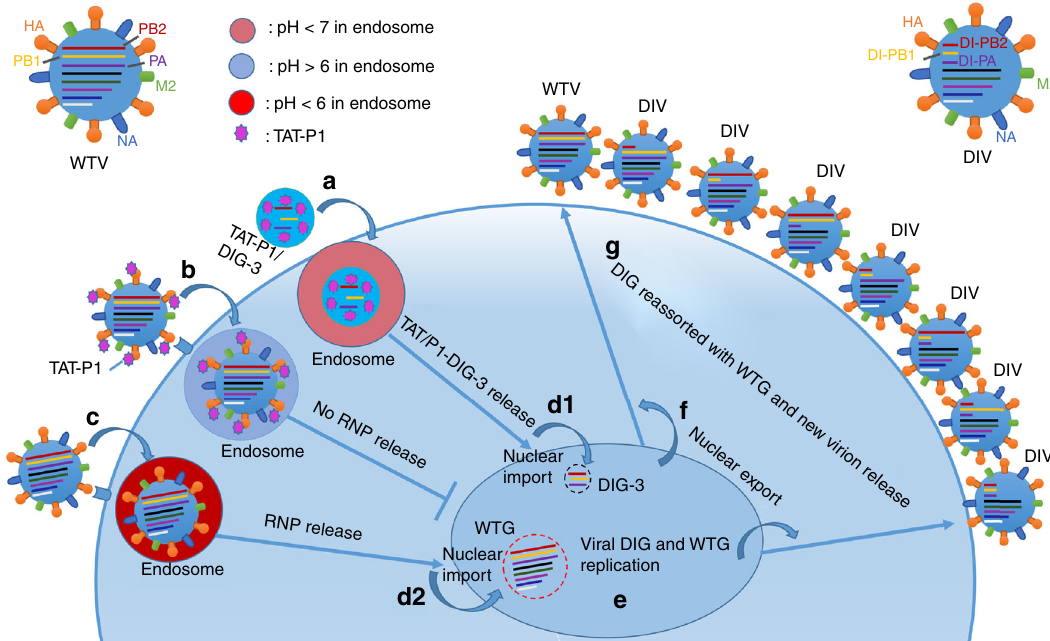
Fig. 8 Schematic model of antiviral mechanism of TAT-P1/DIG-3 in one viral life cycle. When cells are transfected with TAT-P1/DIG-3 and infected with in fl uenza virus, a TAT/P1-DIG-3 are internalized into cells by endocytosis; b Virus can be bound with TAT-P1 and internalized into cells by endocytosis. TAT-P1 can prevent endosomal acidi fi cation to block the release of viral RNP into the cytoplasm and then nuclei; c Some virus particles that are not bound by TAT-P1 might be internalized into cells by endocytosis and undergo endosomal acidi fi cation. d TAT-P1/DIG-3 released from endosomes are imported into nuclei (d1) and viral RNPs released from endosomes are imported into nuclei (d2). e Viral DIG and wild-type genes (WTG) replicate in nuclei. f Newly produced DIG and WTG are exported to cytoplasm. g Viral DIG and WTG are reassorted in cytoplasm and move to the cell membrane to be incorporated into new virions. Seven types of DIV and one type of wild-type virus (WTV) are released from cells to start new virus life cycle. The newly generated DIV can have sustained antiviral activity to competitively inhibit WTV replication in non-transfected